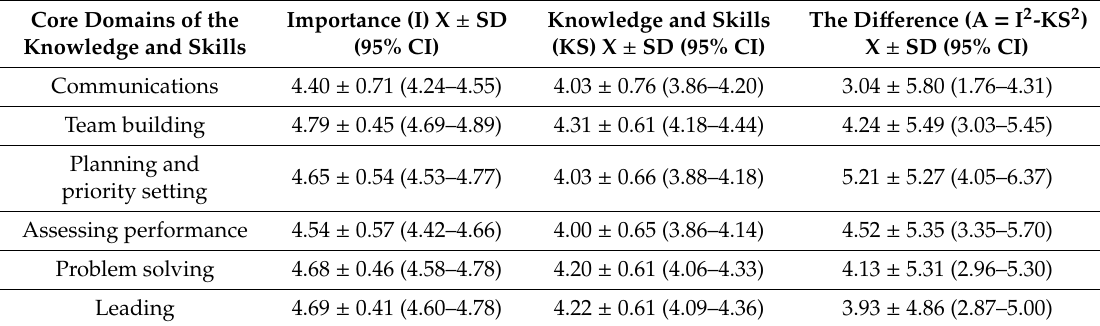
Table 2. Perceived level of importance of knowledge and skills for the task and self-perceived knowledge and skills of managers in primary health care centers.